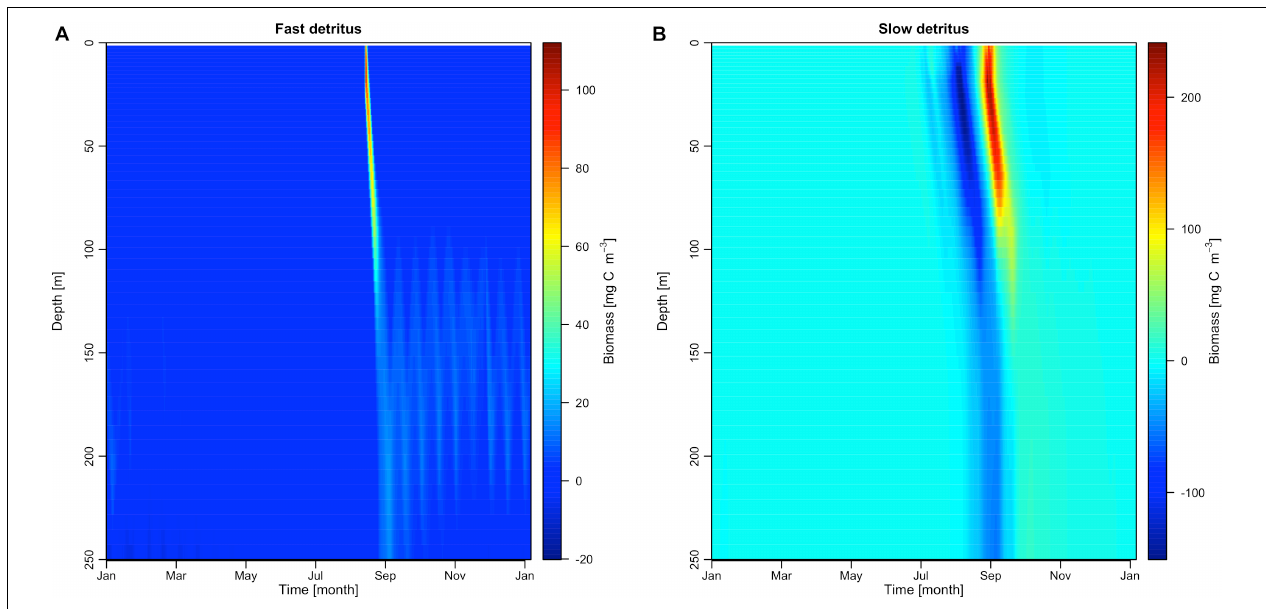
FIGURE 5 | Vertical profile of difference in biomass concentration between full coupling experiment and physical coupling experiment for the fast sinking rate detritus group (A) and the slow sinking rate detritus group (B)